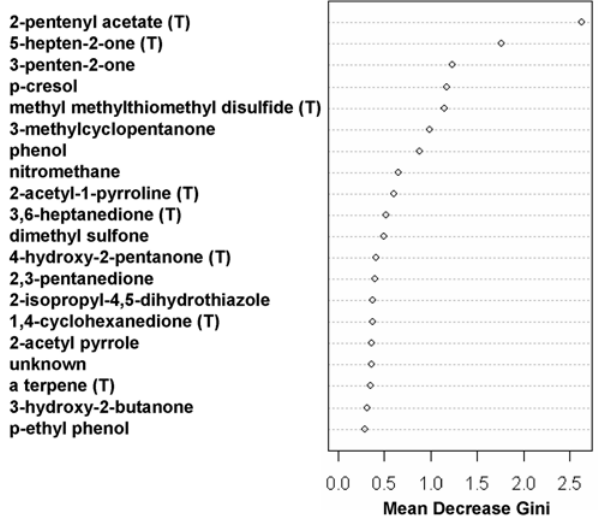
Figure 3. Endogenous compound ranked by their importance in discriminating MHC types across diets. The importance measure is assessed by mean decrease in the Gini index (higher values are more important), a relative measure of group (MHC) differences explained. See the text for details. (T)=tentatively identified from mass spectral